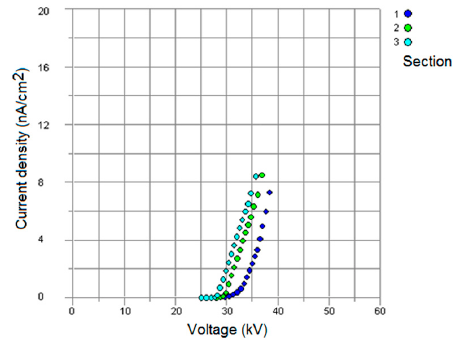
Figure 6. Current density ‐ voltage characteristics at: ( a ) ideal voltage; ( b ) half ‐ wave rectified voltage; ( c ) full ‐ wave rectified voltage; ( d ) the 3rd ‐ order intermittent voltage; ( e ) the 5th ‐ order intermittent voltage; ( f ) the 7th ‐ order intermittent voltage.